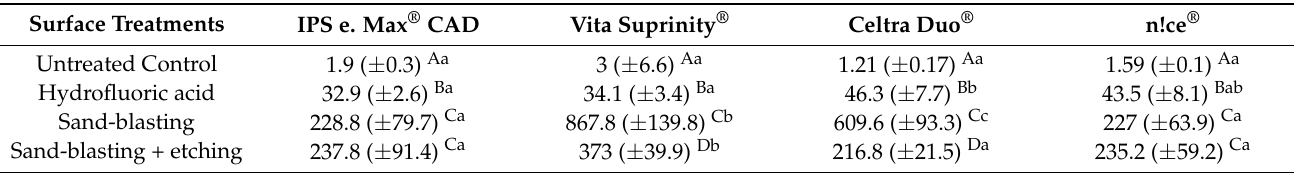
Table 2. Mean (Ra) nm and (standard deviation) of lithium-silicate-based glass-ceramic roughness with different surface